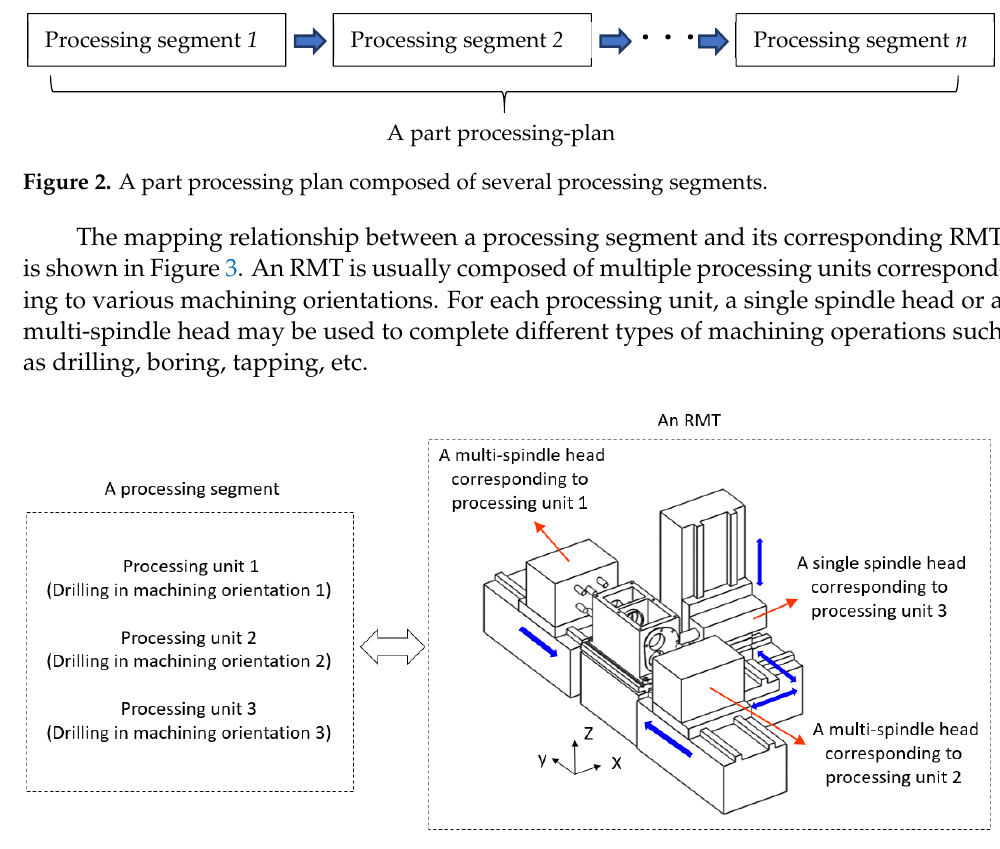
Figure 3. The mapping relationship between a processing segment and its corresponding RMT.